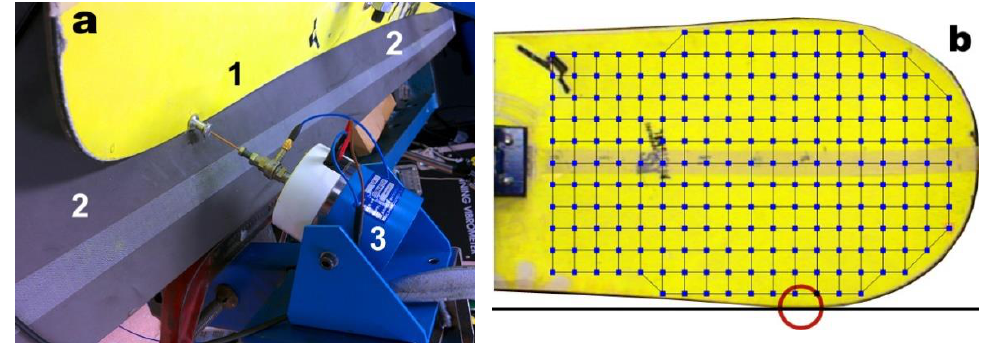
Figure 4. ( a ) Shaker position, connected to the hindmost edge point at the heel; 1: board B; 2: foam surface; 3: shaker; ( b ) laser scanning grid projected on the shovel; the red circle indicates the frontmost edge point.